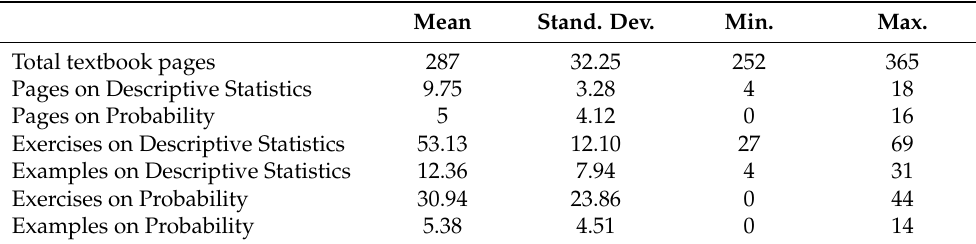
Table 2. Textbooks analysed; mean, standard deviation, minimum, and maximum calculated for the total number of pages, number of proposed exercises, and number of solved examples for each statistics and probability units. Stand.